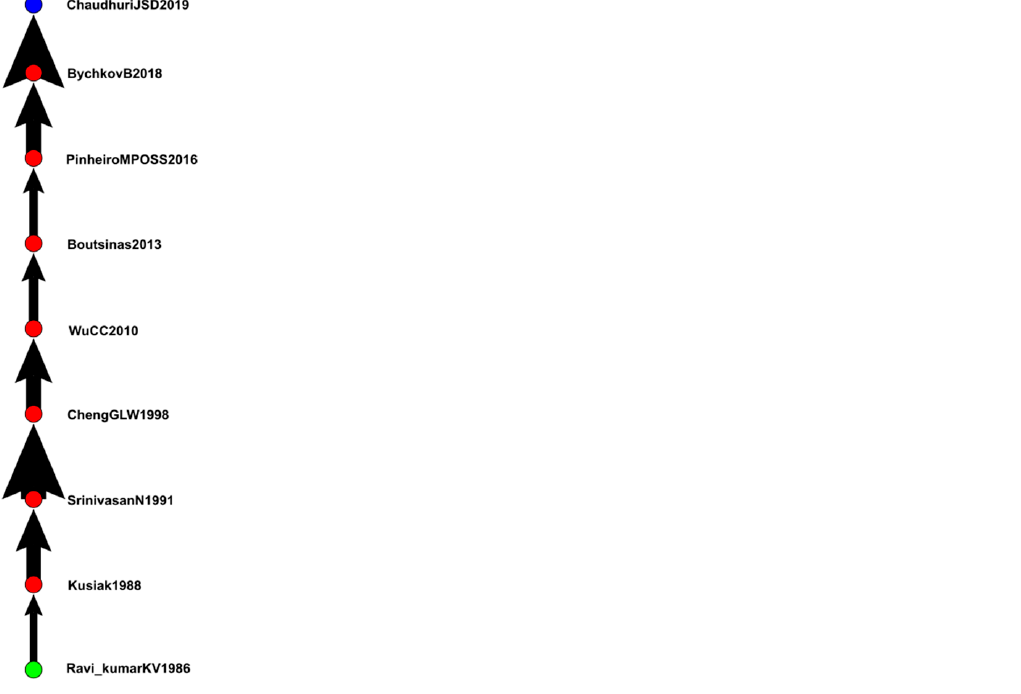
Figure 9. Global main path of FMS composition.